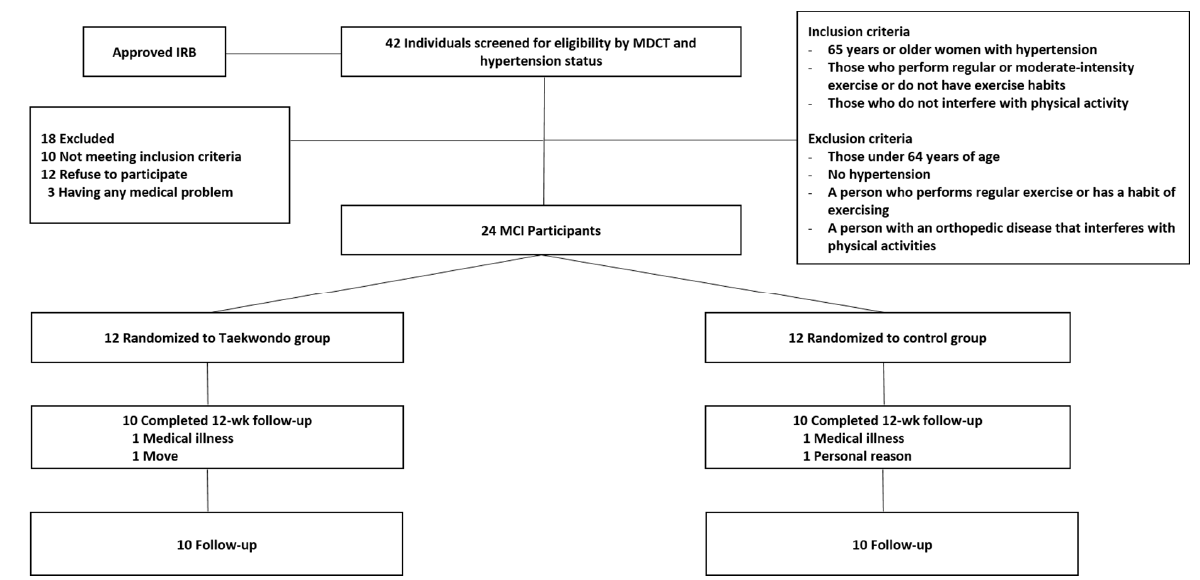
Figure 1. Flow diagram of participants and follow-up. Table 1. Baseline characteristics of socio-demographic, physical characteristics and blood pressure.